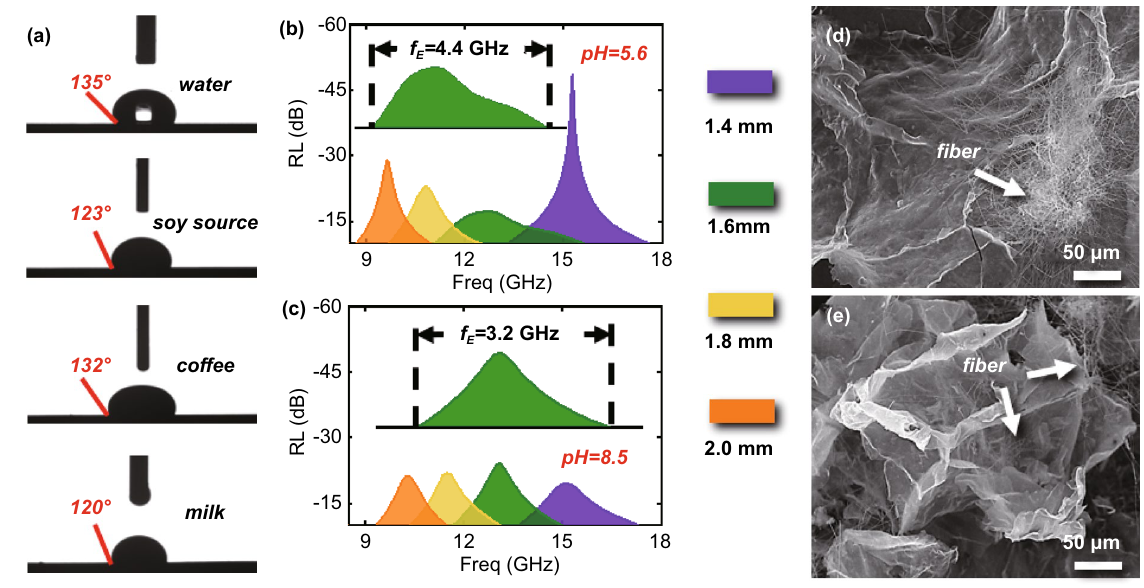
Fig. 7 Environmental adaptability of GC-8. a Apparent contact angles of water, soy sauce, coffee, and milk on GC-8. b , c f E curves of GC-8 after 7-day incubation in aqueous solutions with pH 5.6 and 8.5. The thickness of GC-8 film is < 2.0 mm. Inset shows the corresponding RL curve with the broadest f E . d , e SEM images for GC-8 samples after 7-day incubation in aqueous solutions with pH 5.6 and